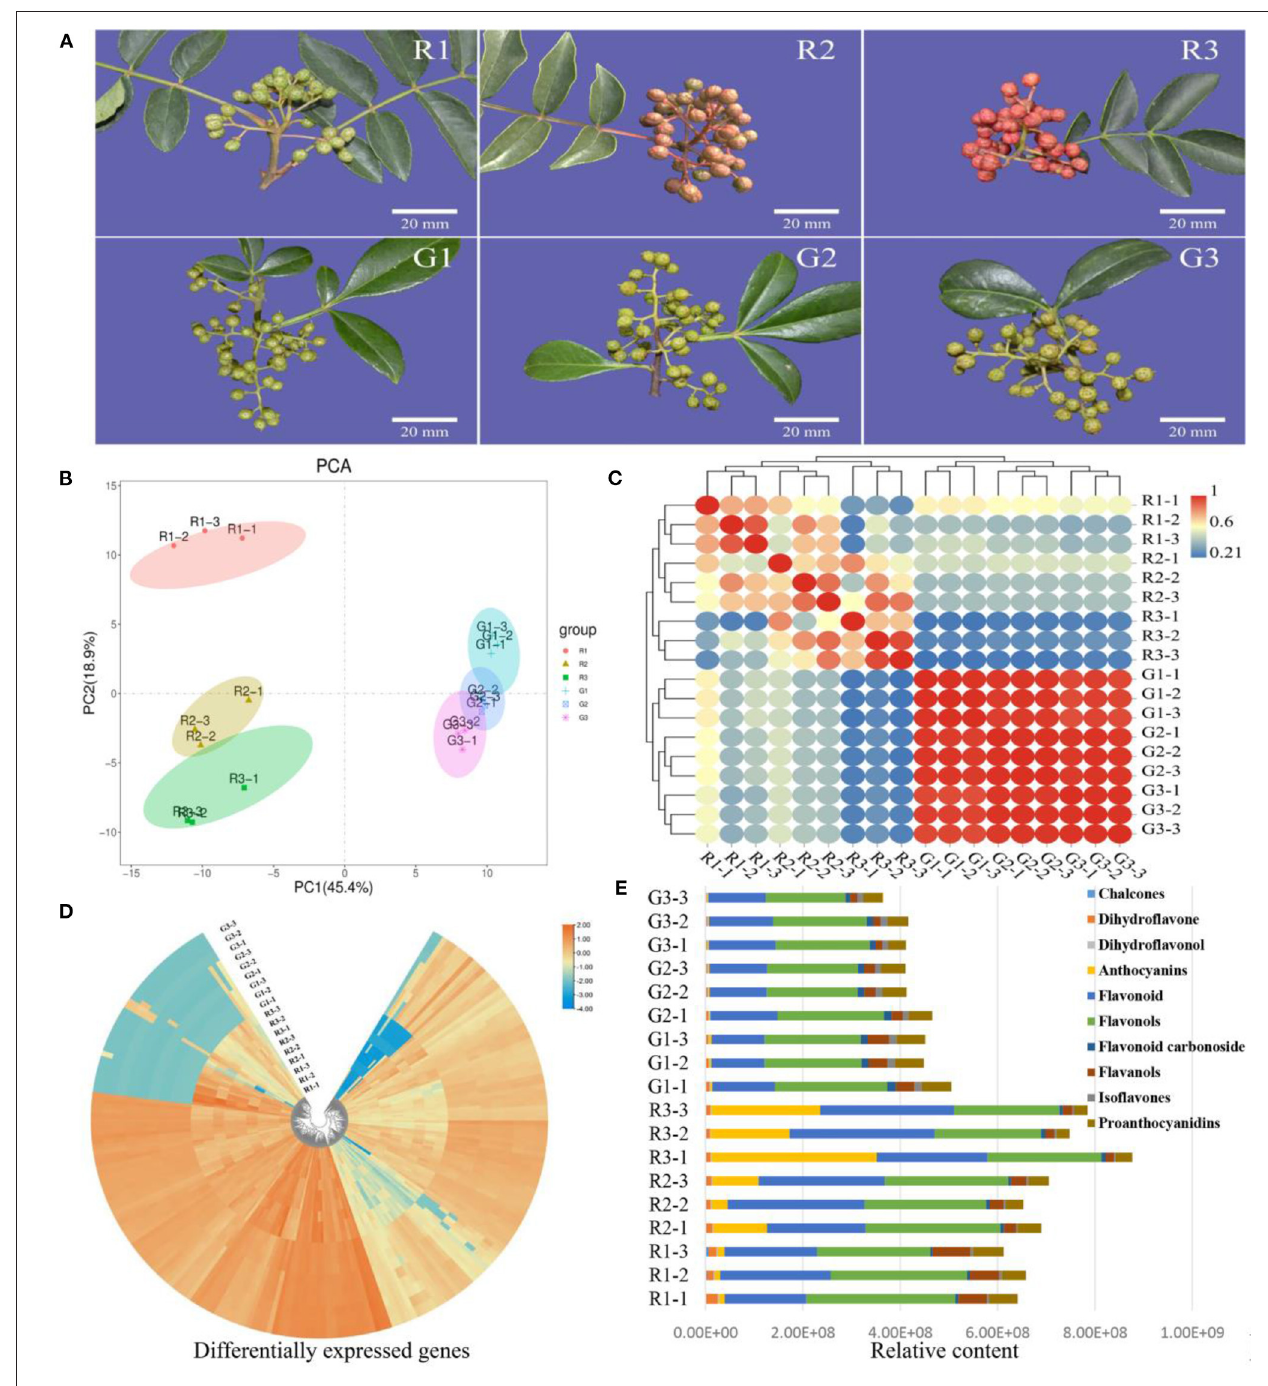
FIGURE 1 | Metabolite analysis of red and green prickly ash fruit at different growth periods. (A) Red and green prickly ash fruit at different growth periods. The scale bar is 20mm. (B) PCA analysis of flavonoid metabolomic data from different growth periods of red and green prickly ash fruit. (C) Correlation analysis between samples. (D) Heat map of metabolite contents in different growth periods of red and green prickly ash fruit. (E) The content and proportion of ten flavonoid classes in different growth periods of red and green prickly ash. were always present at a low level in green prickly ash, during development ( Figure 1E ). Flavonoids and flavonols whereas they increased significantly during development in red were the main flavonoid components at all growth periods prickly of both kinds of prickly ash fruit. However, anthocyanins